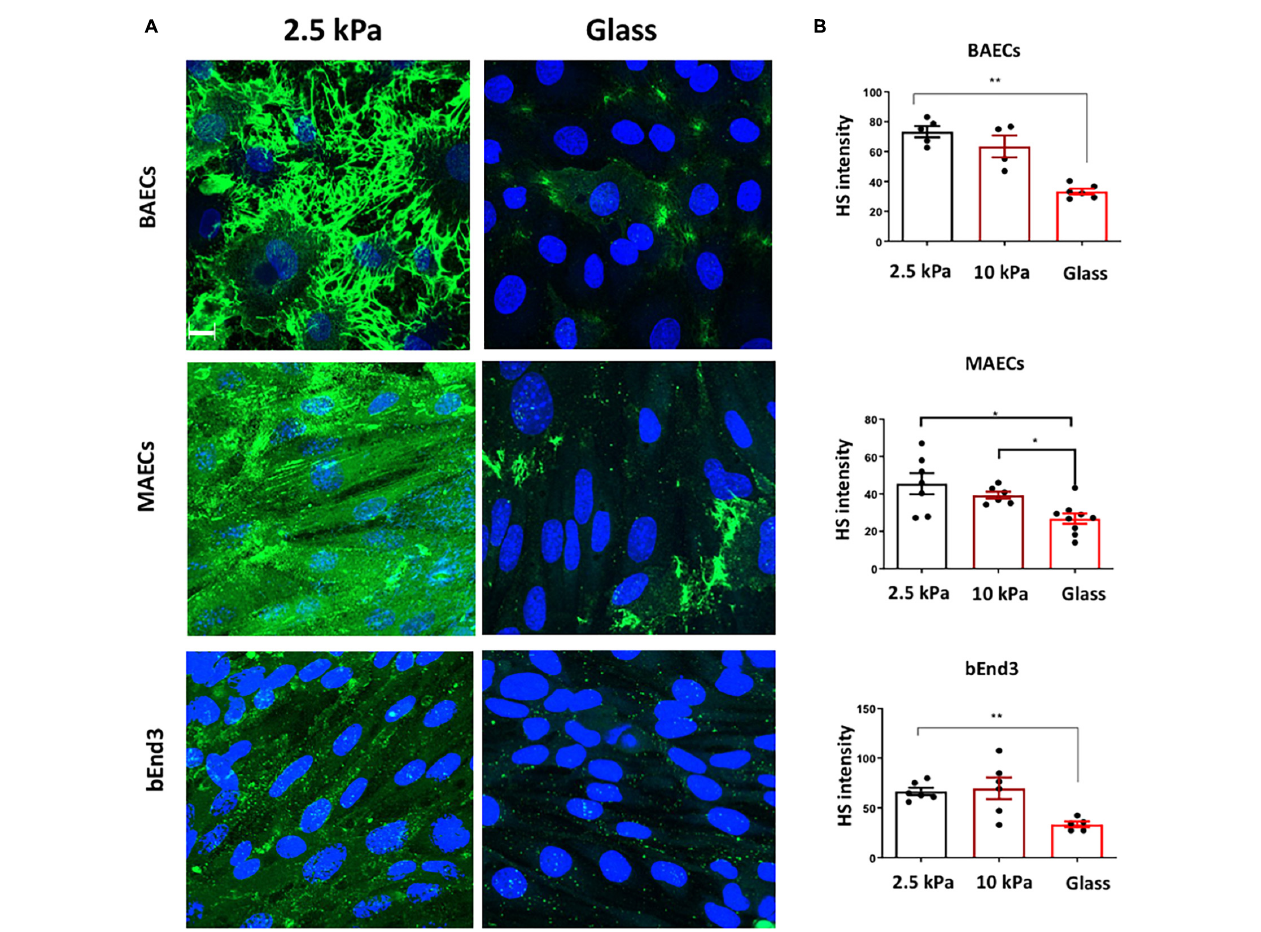
FIGURE 1 | Stiffness inhibits Heparan Sulfate GAG expression on the surface of endothelial cells. (A) Bovine aortic endothelial cells (BAECs), Mouse aortic endothelial cells (MAECs) and brain-derived endothelial cells 3 (BEND3) were cultured onto polyacrylamide gels at stiffness of 2.5 kPa (soft gel), 10 kPa (stiff gel) or on glass until confluent. Heparan Sulfate (HS) (green) expression was assessed by immunostaining. Cell nuclei were identified using DAPI 4 (cid:48) ,6-diamidino-2-phenylindole (DAPI) (blue). Scale bar = 10 µ m. (B) Heparan sulfate expression was quantified as fluorescent intensity. Mean values ± SEM are shown. N = 6. * P < 0.05 and ** P < 0.01 and using a One-way ANOVA test. N.S indicates no statistically significant difference.